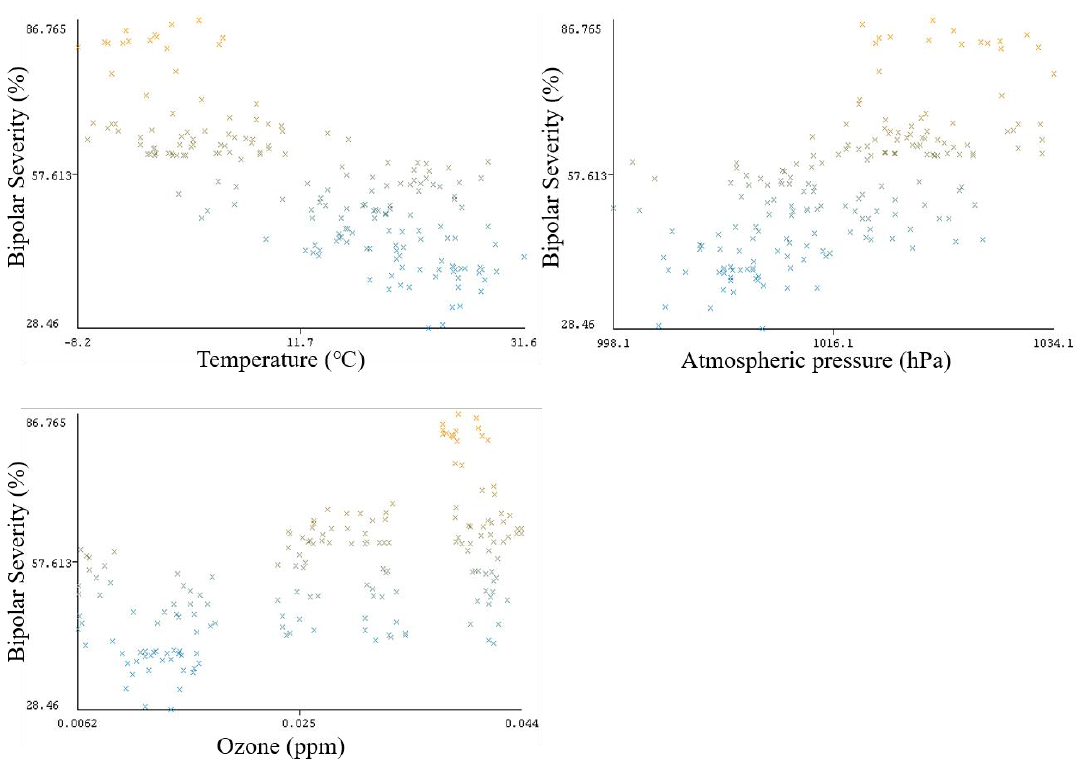
Figure 4. Scatter plot in Weka, of top-ranked weather parameters for Bipolar disorder. Furthermore, we have also analyzed the correlation results among the sensor data with respect to each emotion class. Here, the results also show no or very minimum correlation among the sensor data. Only the readings under “No Emotion” and “Anger” class have small factors of positive correlation between GSR and Respiration sensors, which are 0.325 and 0.456, respectively. This correlation signifies an inverse effect in analyzing the sensor data attributes. In this case, weaker correlation means that there is less similarity in the patterns of the sensed data. This indicates that each sensor data has unique patterns, which can be an important factor in identifying emotional states. In the case of strong correlation, it would indicate that the strongly-correlated attributes can have the same impact in predicting the emotional states, and hence one of them can be considered a redundant attribute and discarded. Table 9. Correlation-based ranking for physiological